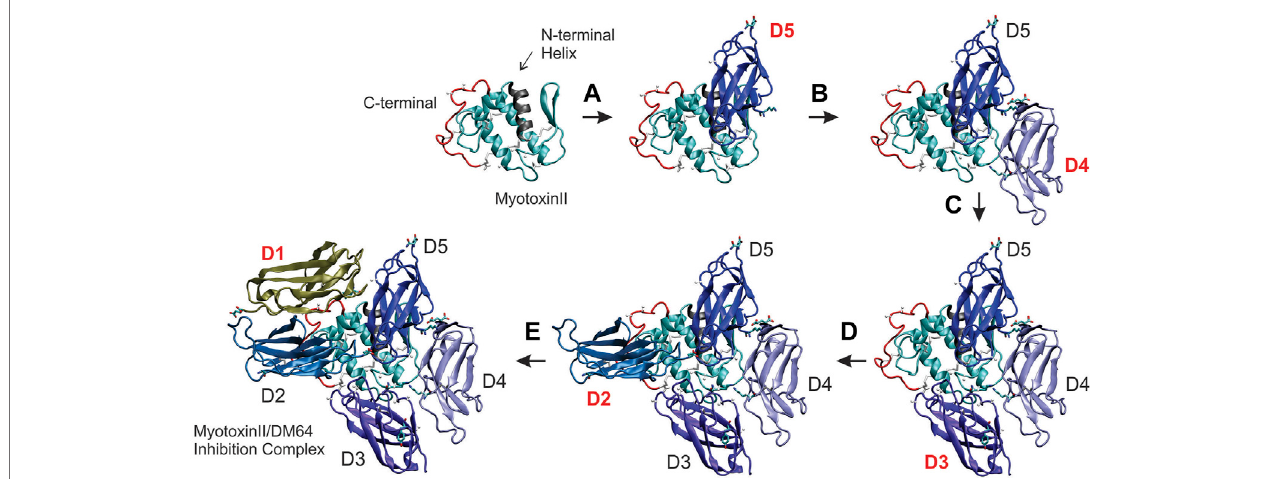
FIGURE6| BuildingthestructuralmodelofDM64dockedwiththecrystalstructureofmyotoxinII.DM64Ig-likedomainswereindividuallymodeledandsequentially docked to myotoxin II (PDB ID 1CLP). Each docking step consisted of a global phase and a local phase when the interaction surface was re fi ned. The fi rst image in the upper left panel of the fi gure shows the ribbon representation of myotoxin II, with its highlighted N-terminal helix (residues 1 to 14; colored in gray) and the C-terminal region(residues100to121;coloredinred). (A) Inthe fi rstdockingstep,the fi fthIg-likedomainofDM64(D5,coloredindarkblue)wasdockedandinteractedmainly with the N-terminal region of myotoxin II. (B) D4 (light blue) was docked at the frontal loop of myotoxin II, followed by (C) D3 (violet). (D) D2 (blue) was docked over the C-terminal region of myotoxin II, together with (E) D1